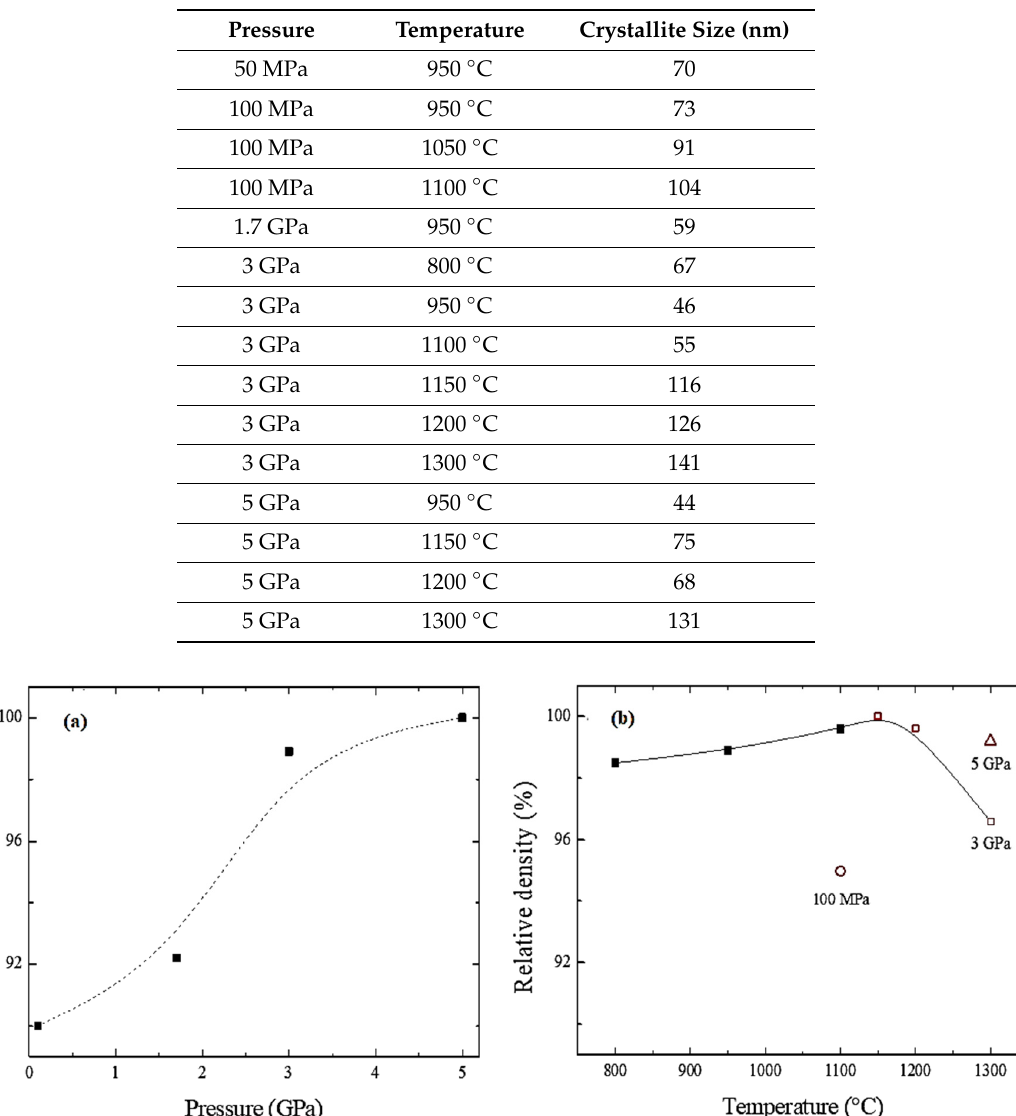
Figure 3. Microstructural evolution of sintered ceramics by conventional SPS at 950 °C at ( a ) 50 MPa, ( b ) 100 MPa, and by HP-SPS at ( c ) 800 °C, 3 GPa and ( d ) 950 °C, 5 GPa.